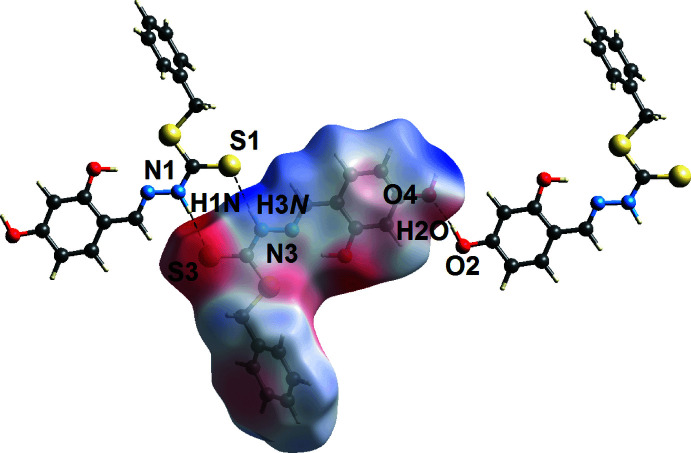
A view of the Hirshfeld surface mapped over the electrostatic potential for the S3-containing mol­ecule in the range −0.055 to +0.134 a.u. The red and blue regions represent negative and positive electrostatic potentials, respectively.